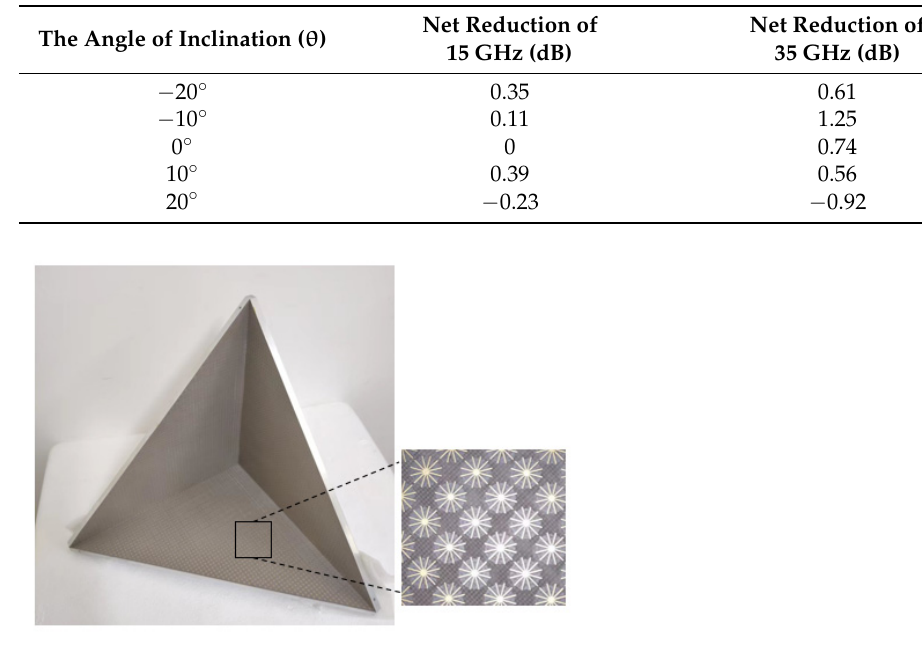
Table 1. Net reduction values for different angles of inclination.